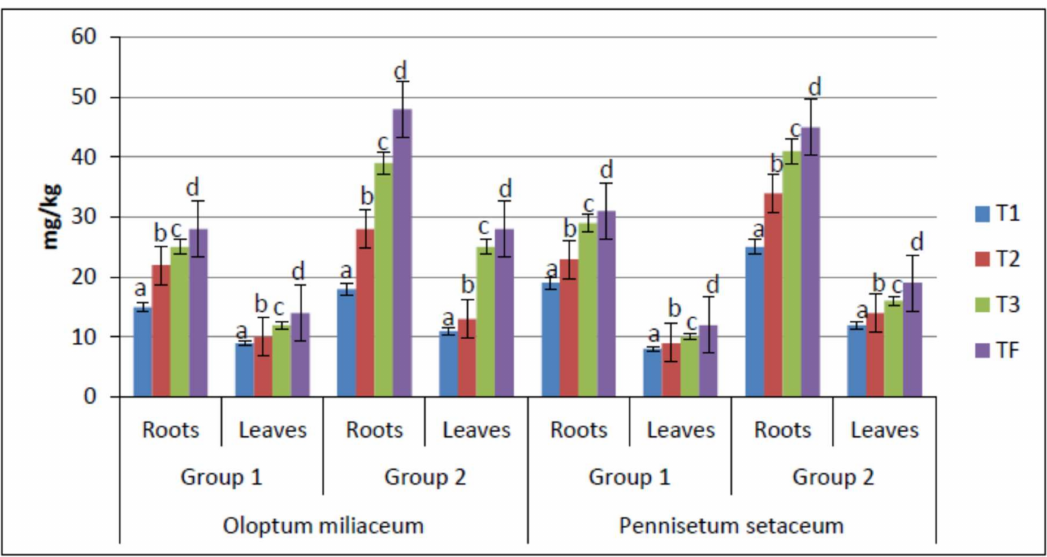
Figure 3. Concentrations of TPHs (mg / kg) in roots and in leaves of Oloptum miliaceum and Pennisetum setaceum for Groups 1 and 2 after 30 (T 1 ), 60 (T 2 ), 90 (T 3 ), and 240 (T F ) days. Values represent mean ± SE. Di ff erent letters indicate means that are significantly di ff erent from each other (Duncan’s test, p <